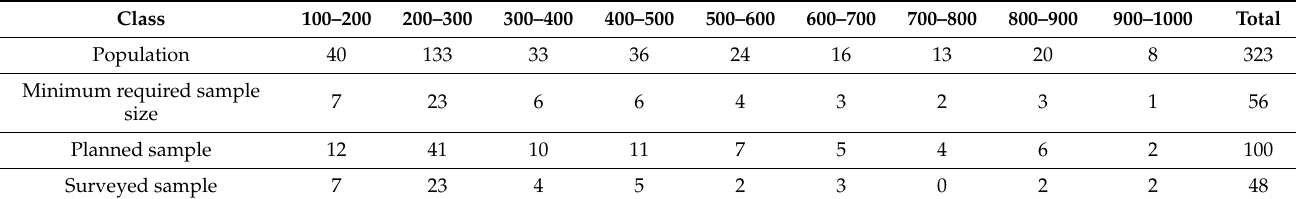
Table 7. Surveyed number of samples for the 100 survey candidates by class.